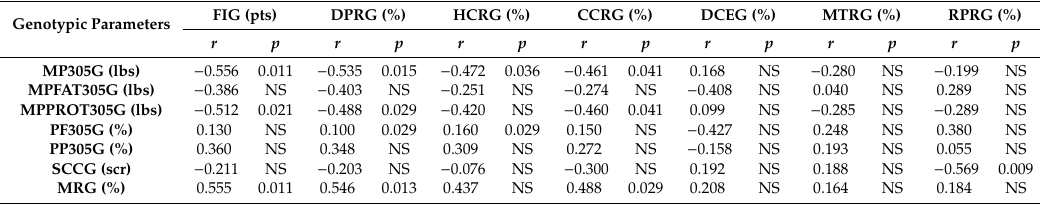
Table 2. Pearson’s correlation coe ffi cients between genomic parameters of production and reproductive traits obtained from primiparous high-producing dairy cows for the HI